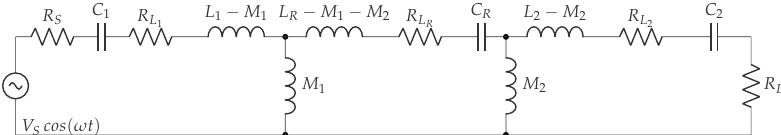
Figure 26. Equivalent scheme of an MRC system with LC